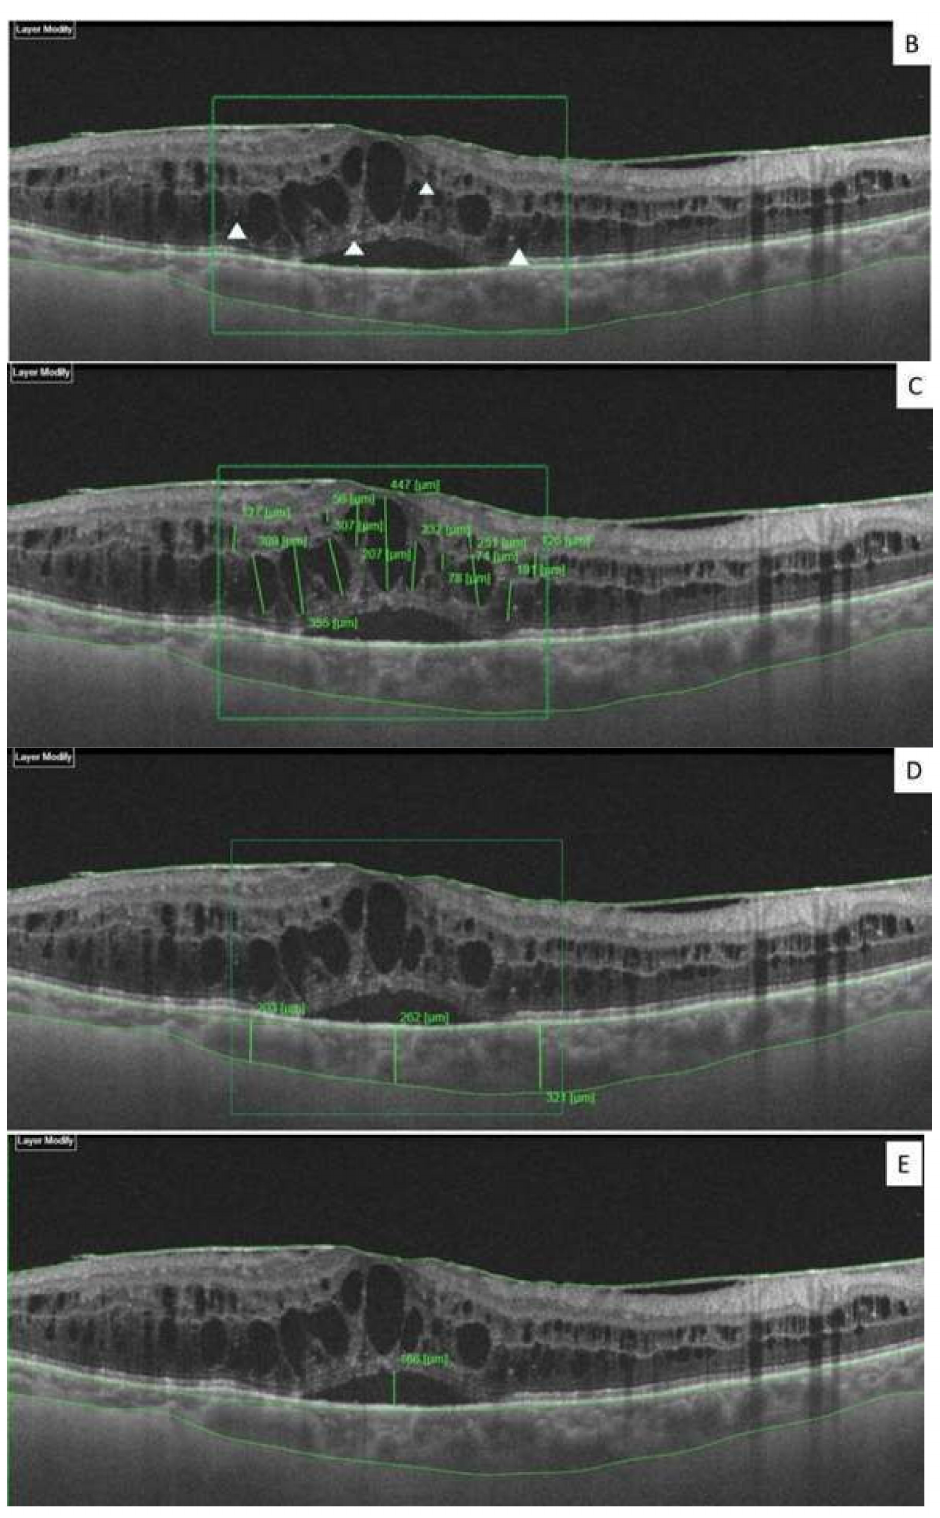
Figure 1. Retinal images. ( A ) Turnover of red dots observable at red free and color fundus photo. ( B ) White triangles indicates the hyper-reflective spots (HRS) in the retina layers of a patient with significant diabetic macular edema (DME), ( C ) intra-retinal cysts (IRC), ( D ) choroidal thickness, and ( E ) serous detachment of neuro-epithelium (SDN)